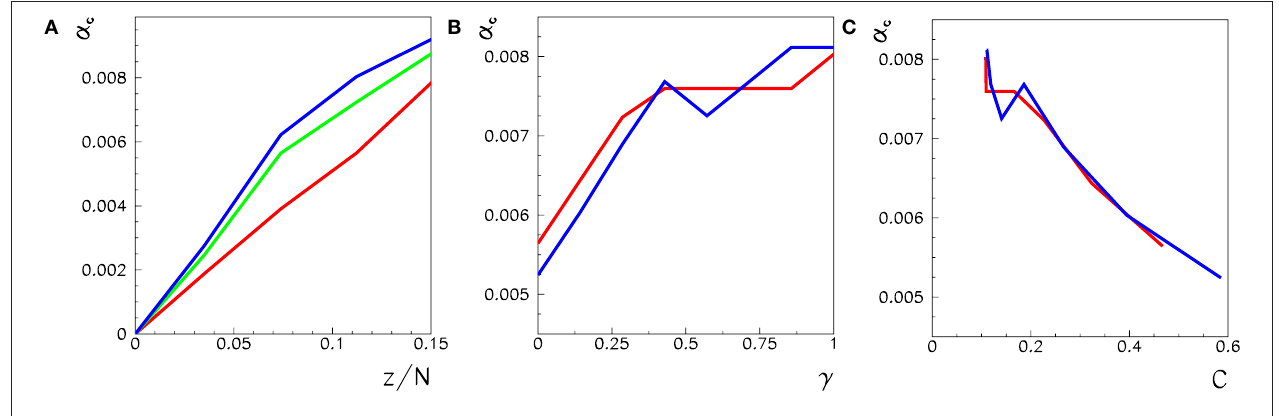
network where the finite dimensional topology is completely lost. (B) Maximum capacity α = P / N , for the same values of N and ϕ * and for connectivity z / N = 0.11, c max as a function of γ , for the 24 3 lattice (red) and for a two dimensional 118 2 lattice (blue). (C) Same data as in (B) , but as a function of the clustering coefficient C